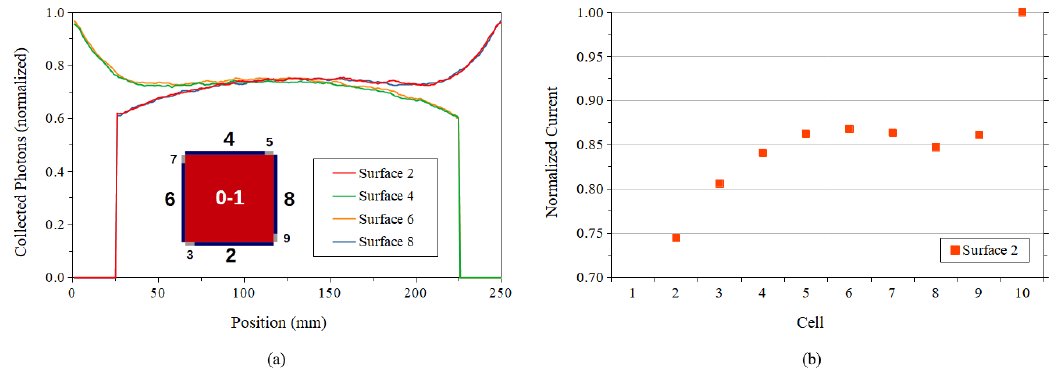
Figure 6. Unshaded LSC panel with four 9-cells PV arrays: ( a ) Normalized number of rays of light collected by the PV cells as a function of the position along the LSC side, which ranges from 0 mm to 250 mm. ( b ) Normalized current produced by each PV cell.